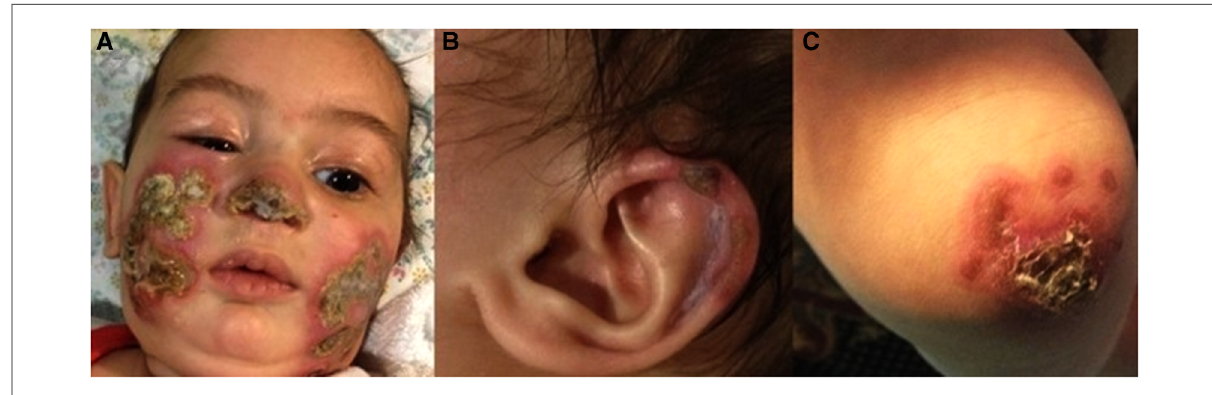
FIGURE 1 ( A – C ) Clinical features on admission at age 5-months: erythematous plaques with central necrosis on the tip of the nose and the cheeks bilaterally ( A ). Ulceration on the helix of the left ear ( B ) Right knee with erythematous plaques with yellow-brown central crusts ( C